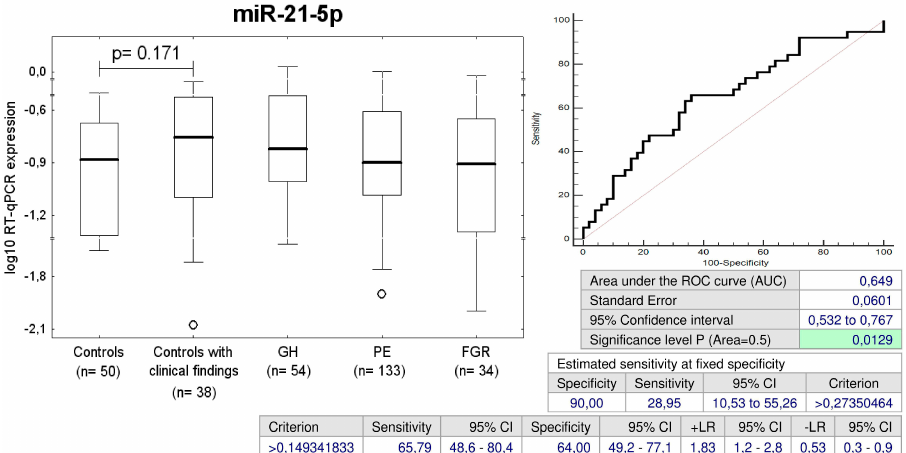
Figure 1. Up-regulation of miR-21-5p in children descending from normal pregnancies that are overweight/obese, prehypertensive/hypertensive and/or have abnormal echocardiogram findings. GH: gestational hypertension; PE: preeclampsia; FGR: fetal growth restriction; ROC: receivers operating characteristic; AUC: Area under the curve; +LR: likelihood ratio positive; –LR: likelihood ratio negative.